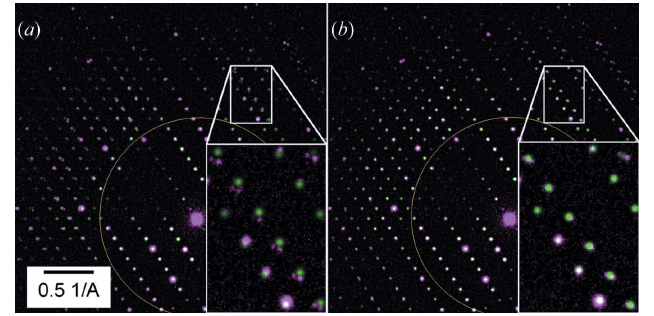
Figure 7 Comparisons of simulation (green) and experimental data (purple) for PED data (DS9) when parabolic distortion effects are ( a ) omitted and ( b ) considered. The overlaid brown circle outlines a resolution of 1 A˚ (cid:5) 1 .